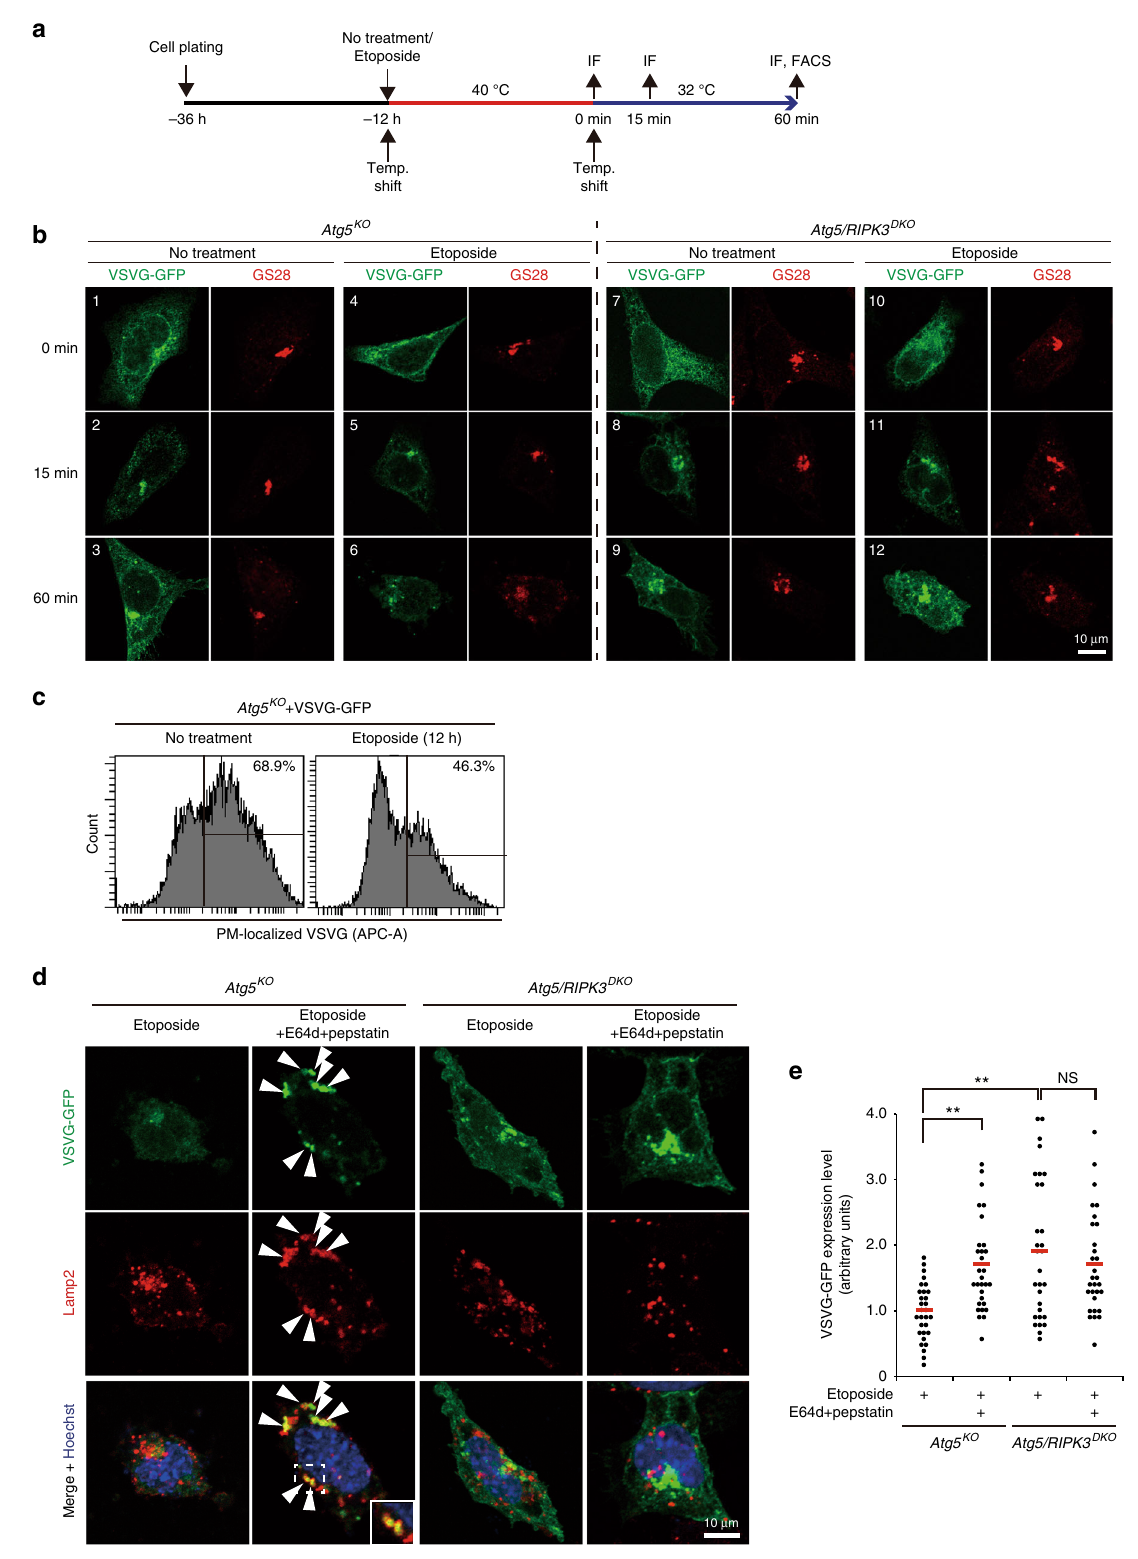
are listed in Supplementary Table 2. Expression was normalized using 18S rRNA as an internal control. VSVG and integrin alpha5 traf fi cking . MEFs were transfected with VSVG – GFP and plated, and then treated with or without etoposide (10 µM), E64d